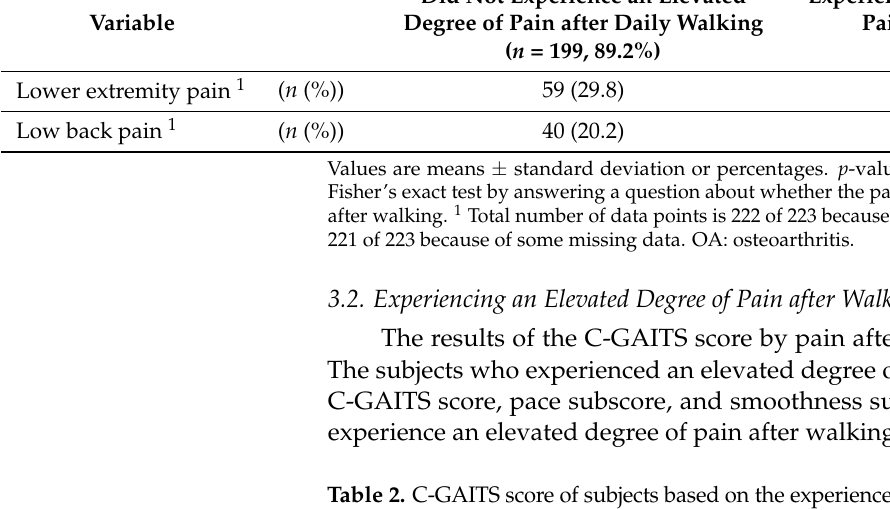
Table 2. C-GAITS score of subjects based on the experience of an elevated degree of pain after walking.